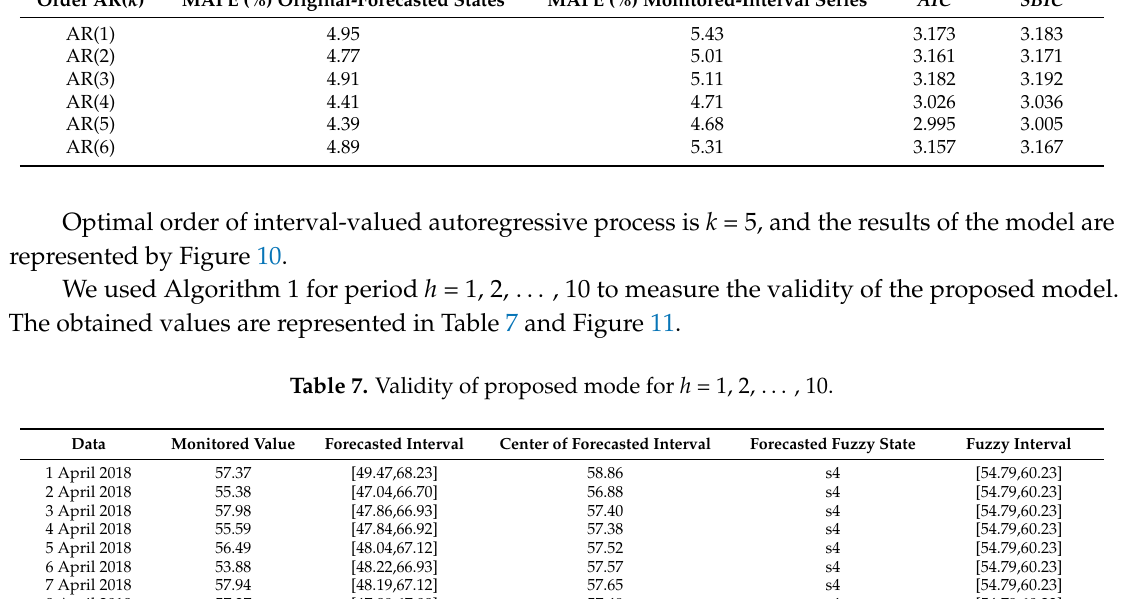
Table 7. Validity of proposed mode for h = 1, 2,…, 10.